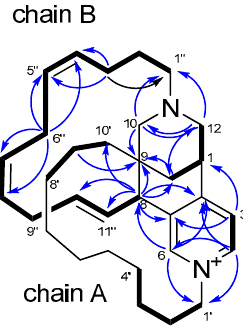
Figure 1. COSY and key HMBC correlations in 1 .